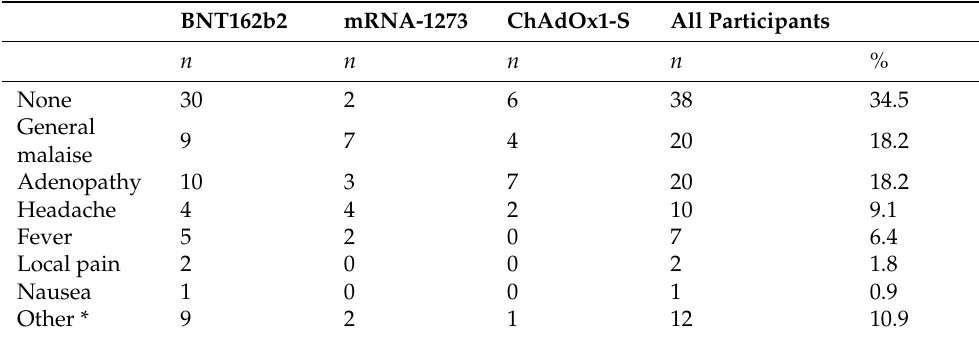
Table 3. Adverse related events after vaccination of breastfeeding mothers included during the study period